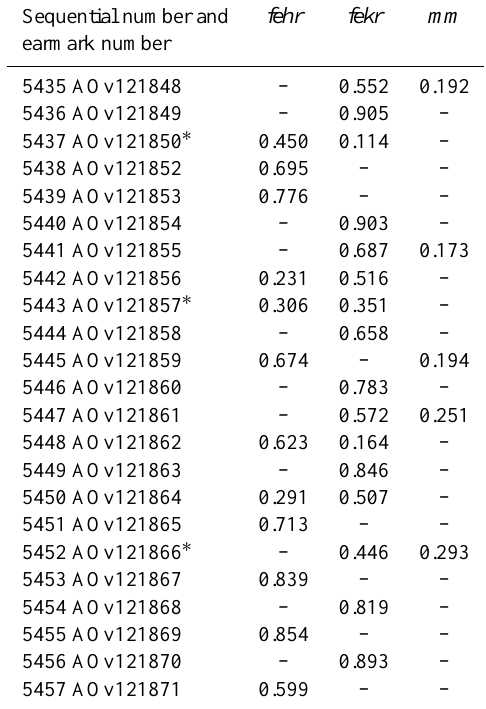
Table 5. Exact list of q values for each of the 23 individuals regard- ing their most probable breed. Individuals marked with an asterisk had only a membership of q <0.500 in any